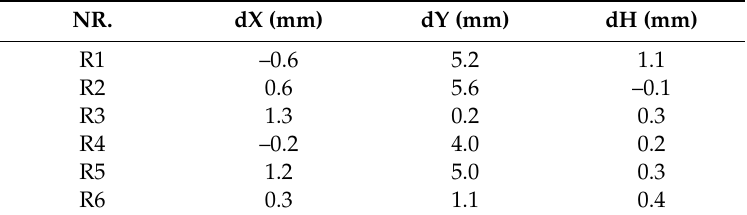
Table 2. Emptying related displacements.